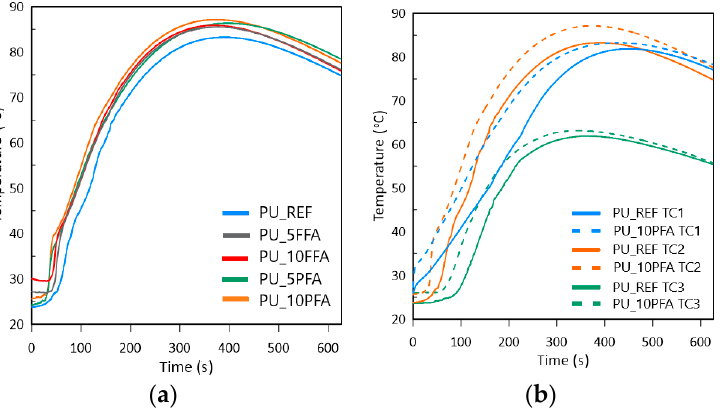
Figure 2. ( a ) Temperature in core foams registered by TC2 during the foaming process for all samples; ( b ) Temperature registered by TC1, TC2 and TC3 for PU_REF and